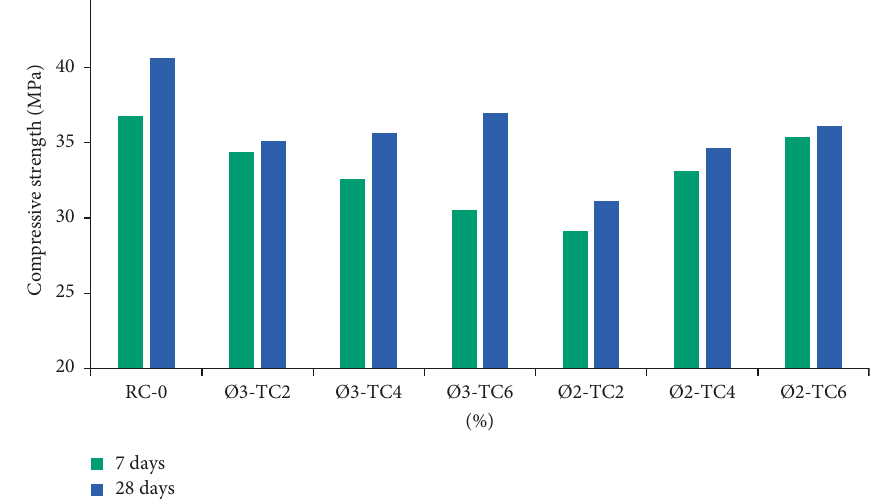
Figure 5: Compressive strength of the translucent concrete at 7 days and 28